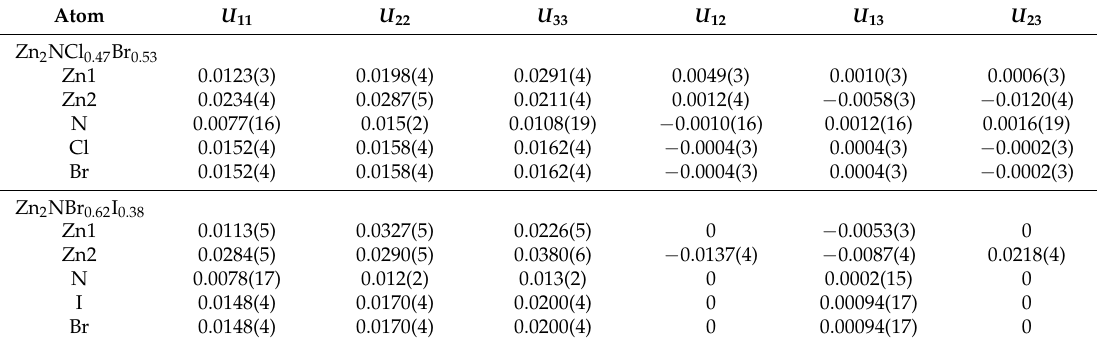
Table 4. Anisotropic displacement parameters (Å 2 ) for Zn 2 NCl 0.47 Br 0.53 and Zn 2 NBr 0.62 I 0.38 .